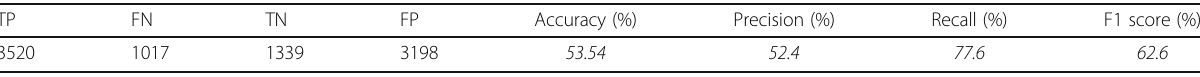
Table 7 Security of the proposed method against second-order SPAM features